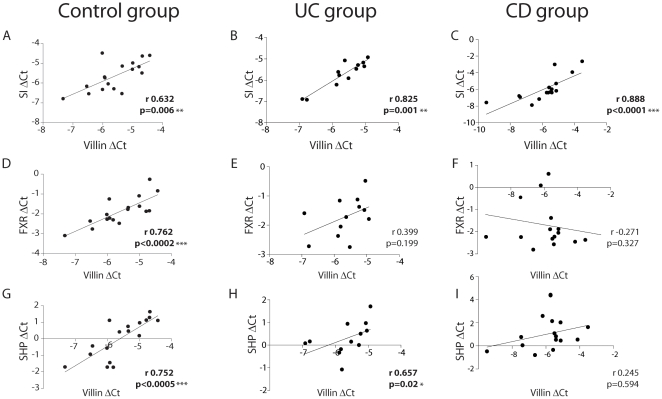
FXR and SHP correlate with Villin in healthy controls but not in Crohn's disease patients.Ileal mRNA expression of SI, FXR and SHP were related by regression analyses to ileal mRNA expression of differentiation marker Villin in healthy controls (A, D, G), ulcerative colitis (B, E, H) and Crohn's disease patients (C, F, I). Spearman's coefficients and p values are shown. Values in bold show statistically significant correlations; *p<0.05; **p<0.01, ***p<0.001.